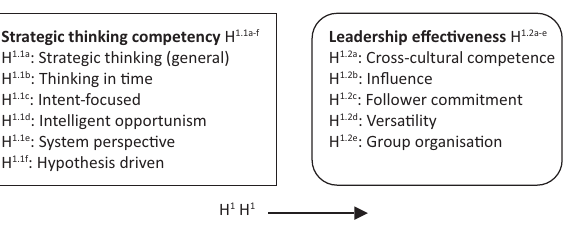
FIGURE 1: Proposed hypothesised framework of the relationship between strategic thinking competency and leadership